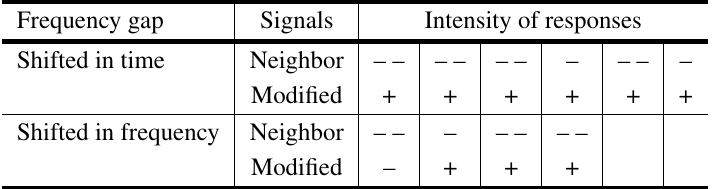
Responses of territorial males Basileuterus leucoblepharus to a neighbor song or to a neighbor signal with the main frequency gap modified in the time domain (n=6) or in the frequency domain (n=4). Frequency gap Signals Intensity of responses Shifted in time Neighbor Modified Shifted in frequency